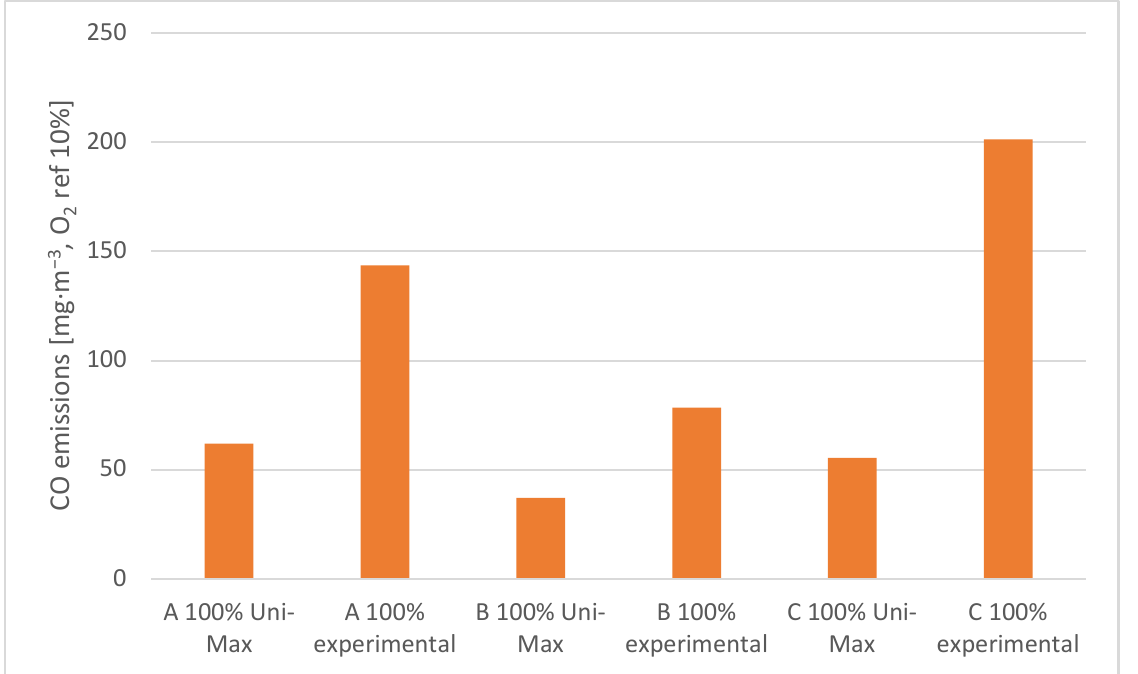
Figure 7. Comparison of average statistical CO emissions from the combustion of three types of wood pellets in two different burners at full load.